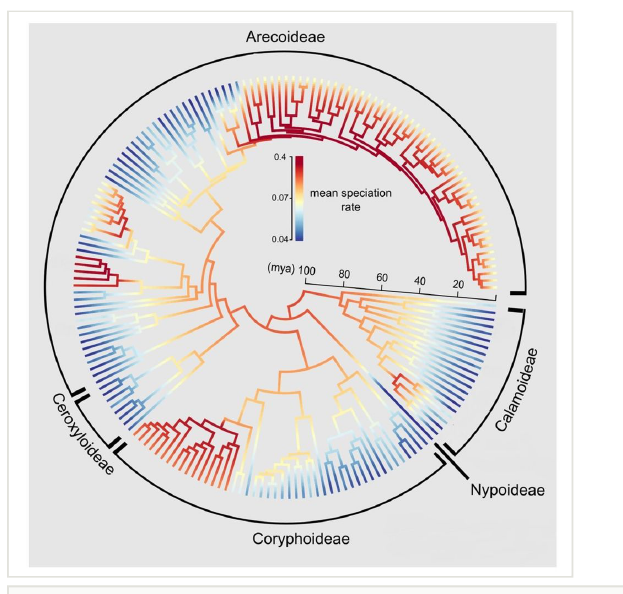
Global diversi fi cation of palms. Branches are coloured by mean diversi fi cation rates across the time-calibrated generic-level phylogeny of palms estimated using Bayesian Analysis of Macroevolutionary Mixtures